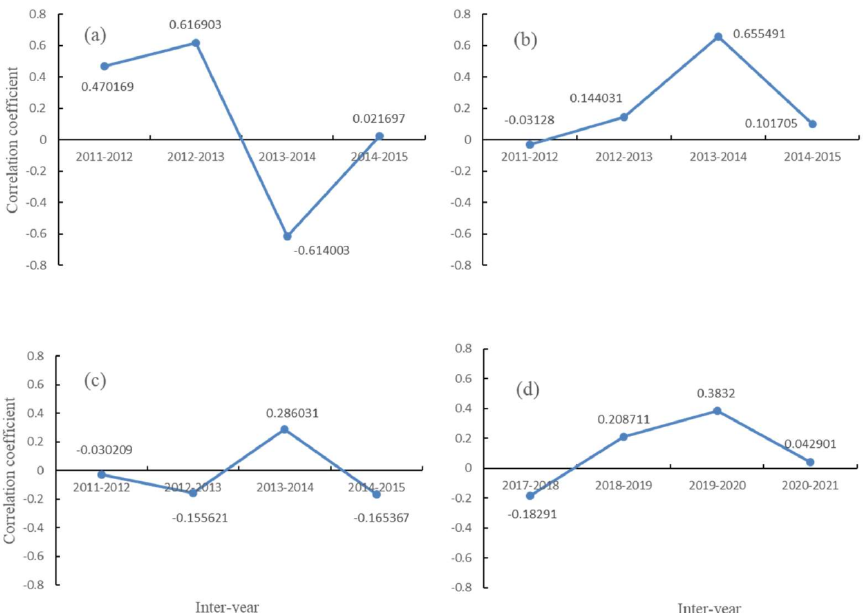
Figure 4. The strong earthquakes in Yunnan Province from 2011 to 2021 and the changes in the correlation coefficient of gravity and magnetic field within the three-year earthquake area before the earthquakes. ( a ) Yingjiang M s 6.1 earthquake in 2014; ( b ) Ludian M s 6.5 earthquake in 2014; ( c ) Jinggu M s 6.6 earthquake in 2014; ( d ) Yangbi M s 6.4 earthquake in